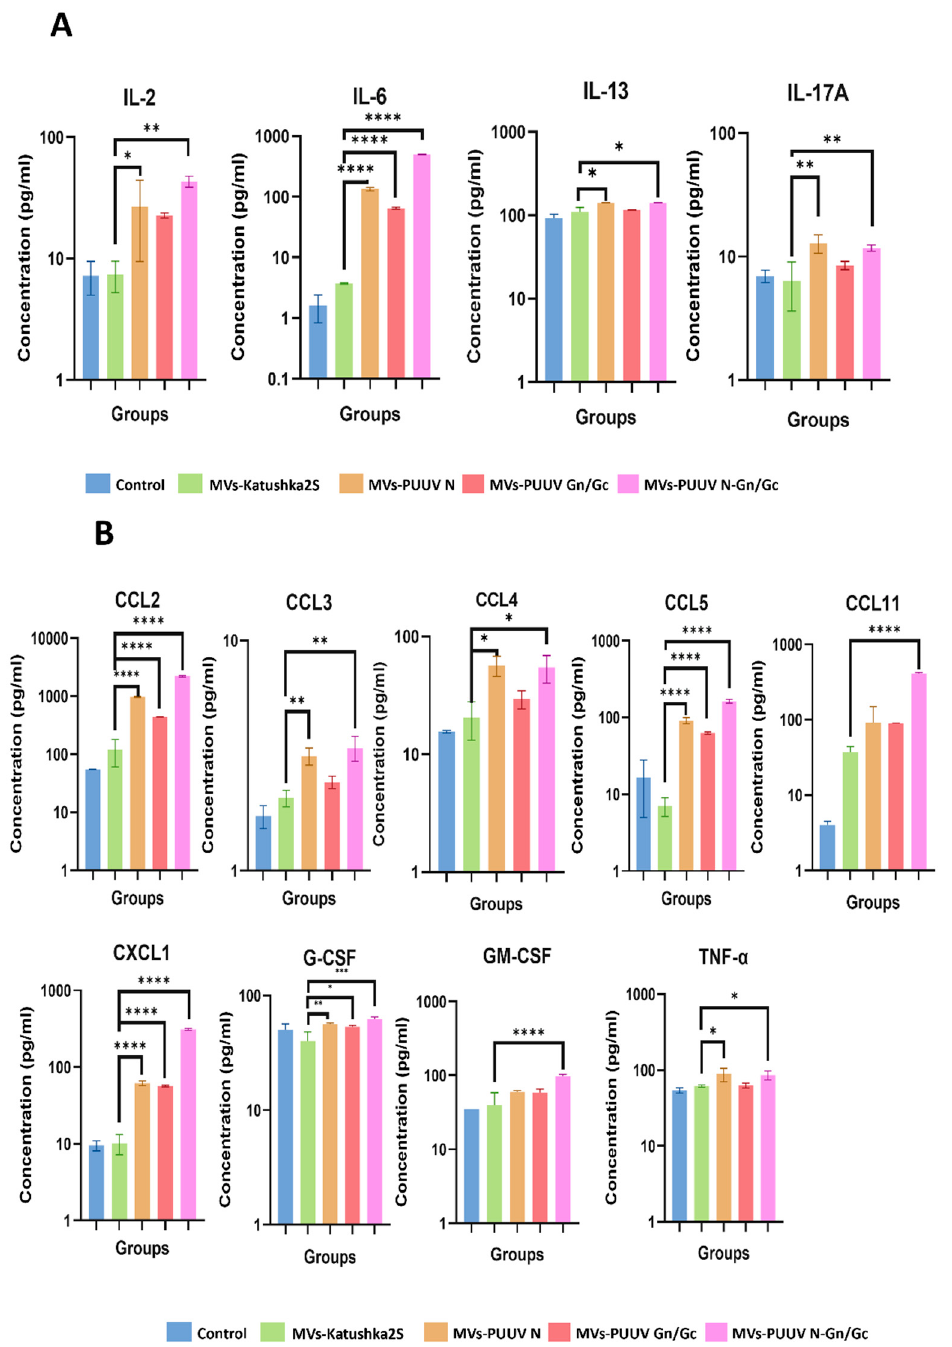
Figure 5. Cytokines and chemokine analysis of MVs cargo. Cytokine and chemokine levels were analyzed in MVs carrying PUUV N, PUUV Gn/Gc and combined PUUV N and Gn/Gc proteins, using Multiplex analysis. MVs generated from non-transduced as well as transduced with LV-Katushka2S mMSCs were used as control. MVs (50 µ L in each well) with total protein (10 µ g) were loaded into the well. ( A )—Interleukin levels; ( B )—cytokine and chemokine levels. Data is represented as median ± SD. * p < 0.05, ** p < 0.01, *** p < 0.005, **** p < 0.0001 . A p -value < 0.05 was considered statistically significant.